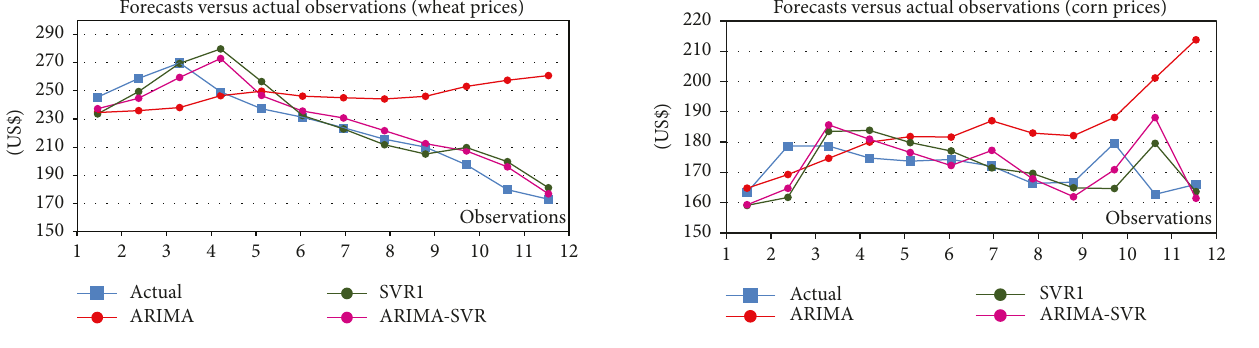
Figure 13: Forecasts of corn prices versus actual observations for the 12 testing records (with the use of ARIMA, SVR , and the 1 proposed ARIMA-SVR models).